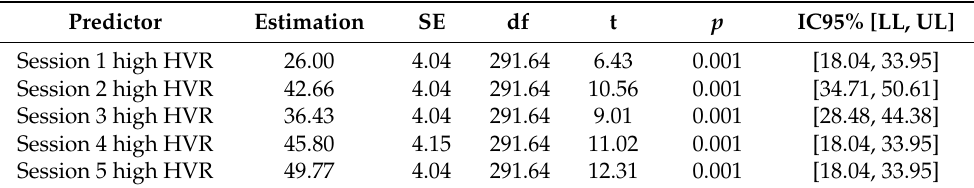
Table 6. Evolution of high HRV values from session to session in cycle 1.